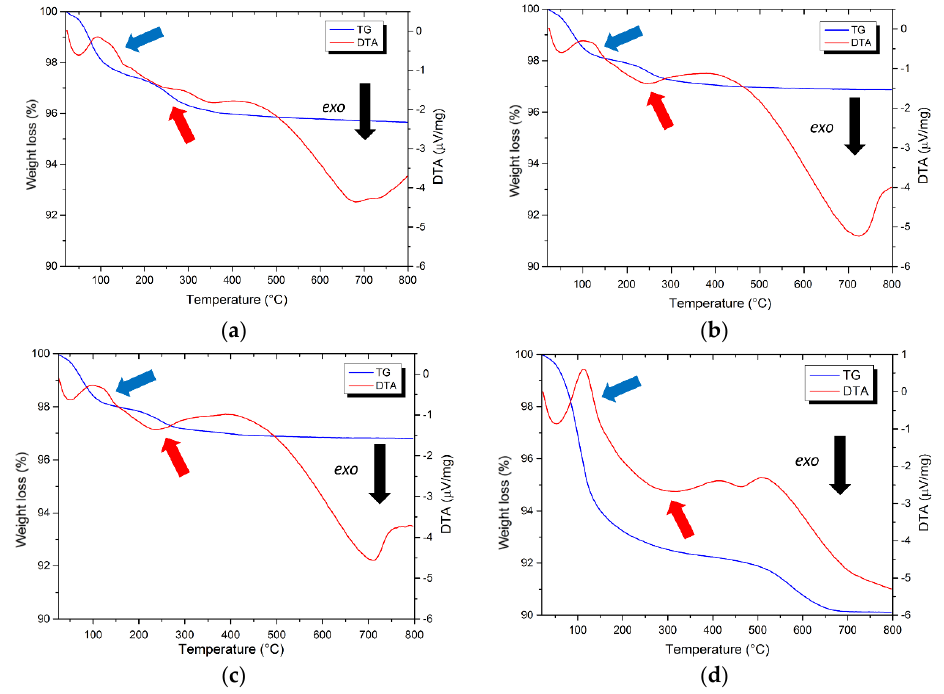
Figure 3. ( a ) TG-DTA of I1.0Cu / P25; ( b ) TG-DTA of D1.0Cu / P25; ( c ) TG-DTA of C1.0Cu / P25 and ( d ) TG-DTA of I1.0Cu / TiO